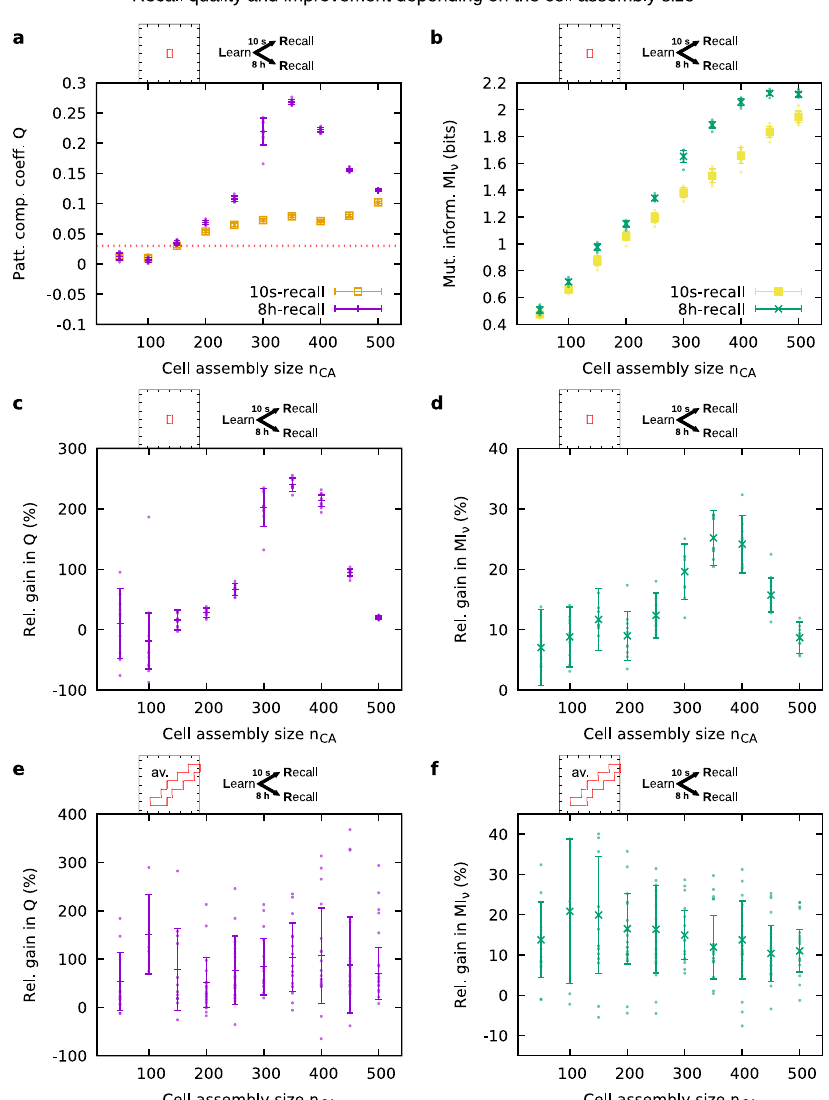
Fig. 5 Recall quality 10 s and 8 h after learning and resulting relative gain as a function of the cell assembly size. a Pattern completion coef fi cient 10 s (orange) and 8 h (purple) after learning. The dotted red line indicates the threshold for memory functionality ( Q ≥ 0.03). b Mutual information of the neuronal activities 10 s (yellow) and 8 h (green) after learning. c Relative gain in pattern completion coef fi cient between 10 s and 8 h after learning. d Relative gain in mutual information of the neuronal activities between 10 s and 8 h after learning. a – d Averaged over ten trials; parameter values: w ie / h 0 = 4, w ii / h 0 = 4. e Relative gain in pattern completion coef fi cient, f relative gain in mutual information, averaged over the mean gain values (from ten trials) of all inhibition parameter sets that yielded functional memory for the respective cell assembly size (i.e., the sets with Q (10s-recall) ≥ 0.03, for size 150 cf. the red boxes in Fig. 4). Error bars indicate in a , b , the standard deviation across ten trials, in c , d , the error propagated from a , b , and in e , f , the error propagated from the standard deviations (from ten trials) of the functional parameter